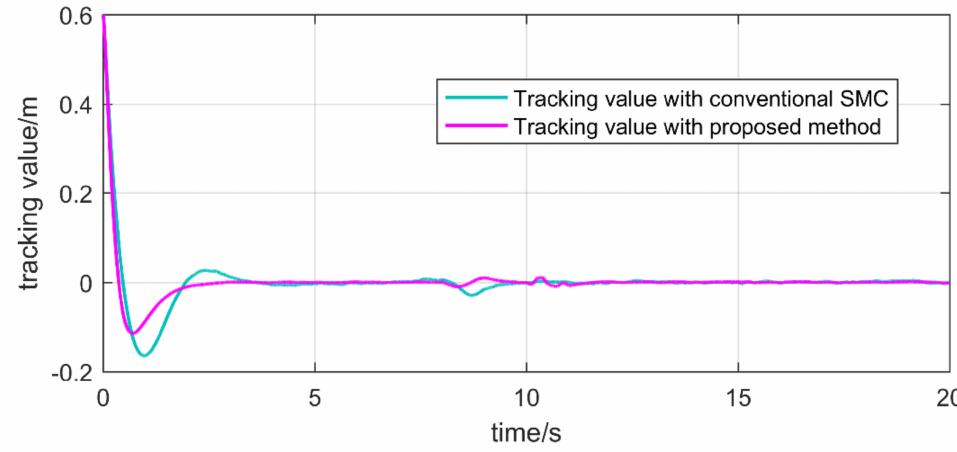
Figure 10. Trajectory tracking of position z .